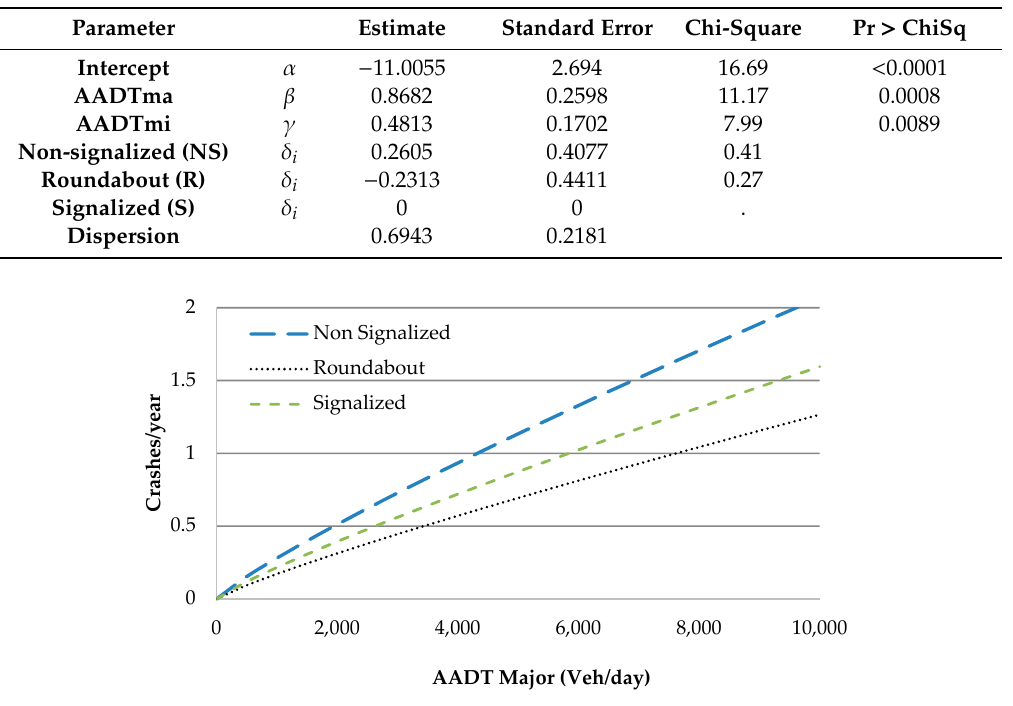
Table 6. Regression coe ffi cient, standard error, and p-value of the intersection SPFs.